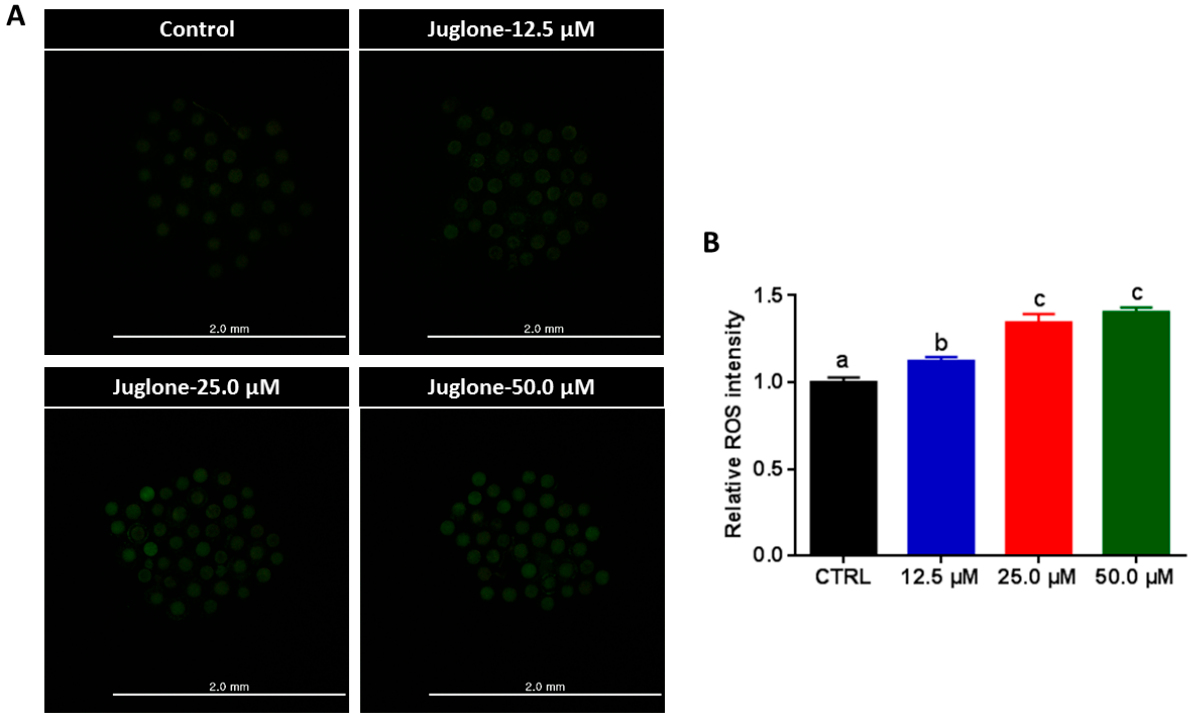
Figure 4. Intracellular reactive oxygen species (ROS) levels following juglone treatment. ( A ) 2,7-Dichlorodihydrofluorescein diacetate (H 2 DCFDA) staining of oocytes. ( B ) The relative ROS fluorescence intensity in the in vitro matured oocytes analyzed by ImageJ. Scale bar = 2.0 mm. The different letters on the columns reflect statistical significance ( p < 0.05).